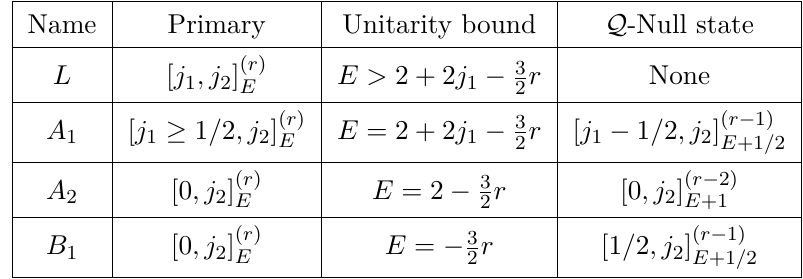
Table 12. Q -shortening